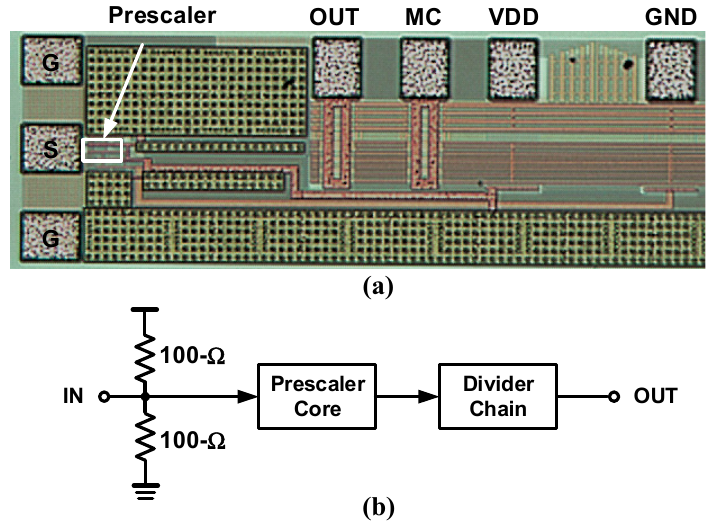
Figure 7. ( a ) Die micrograph of the fabricated prescalers, including a prescaler core, a fixed divider chain and DC pads for the power supply and modulus control; ( b ) Test structure.